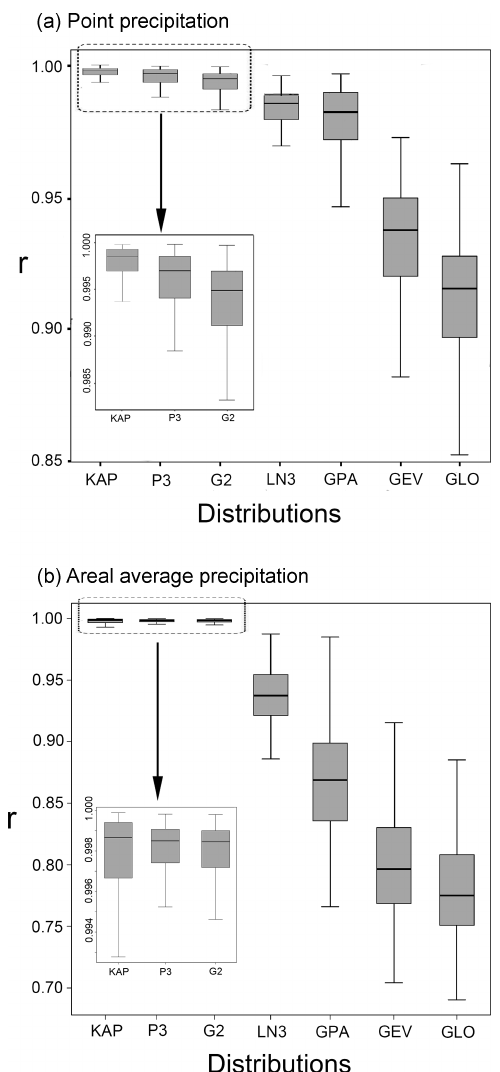
Figure 6. Standard box plots of r for all 7 distributions evaluated for wet-day series of (a) point precipitation and (b) areal average precipitation depths.